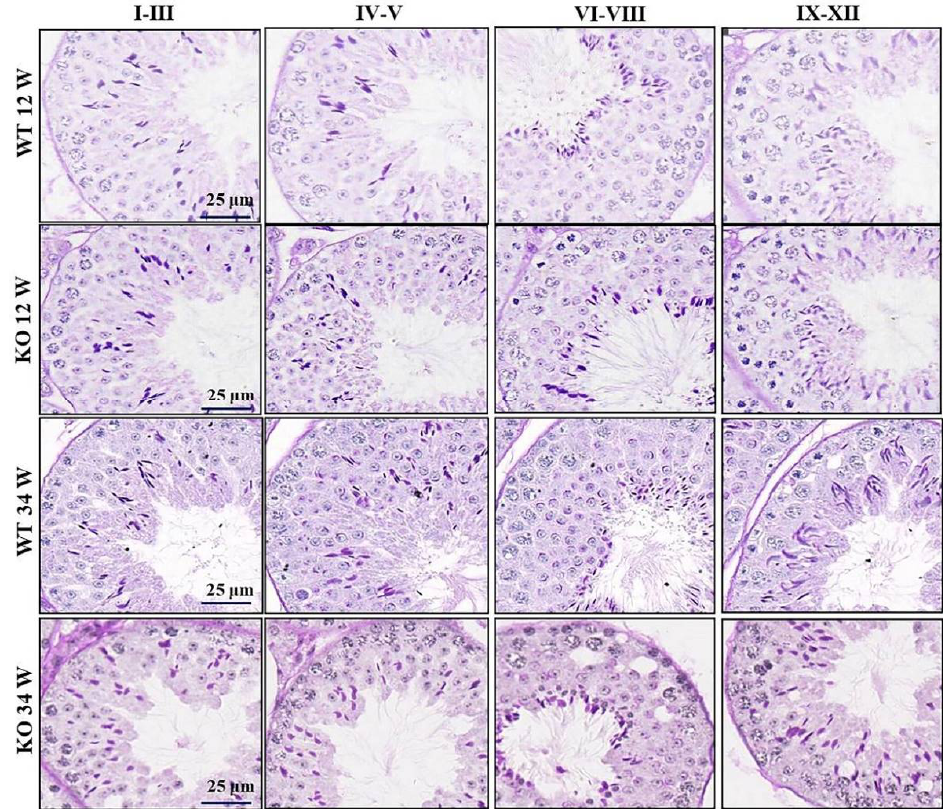
Figure 4. Development and morphology of testes in O22Rik knockout (KO) mice. Histological analysis of testis sections in O22Rik WT and KO mice at 12 and 34 weeks, respectively. Sections were stained with periodic acid–Schiff + hematoxylin (PAS). Different stages show the cycle of the seminiferous epithelium for the mouse.